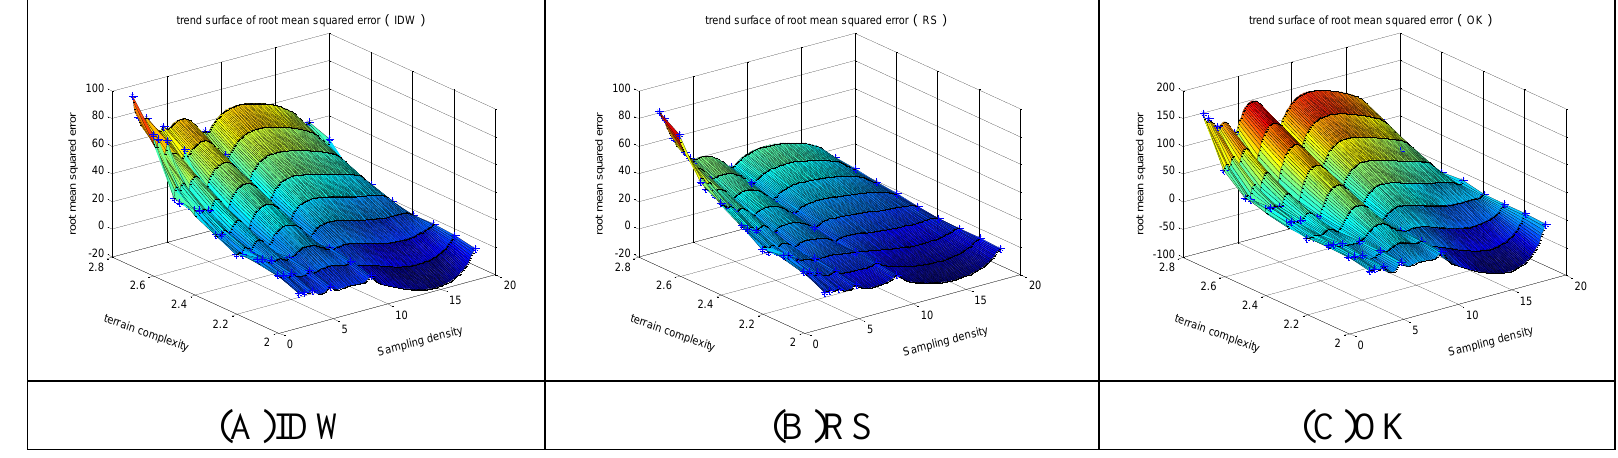
Figure 10. The RMSE s of the 3 methods in selective sampling. ( A ) The trend surface of RMSE s for IDW; ( B ) The trend surface of RMSE s for RS; ( C ) The trend surface of RMSE s for OK.